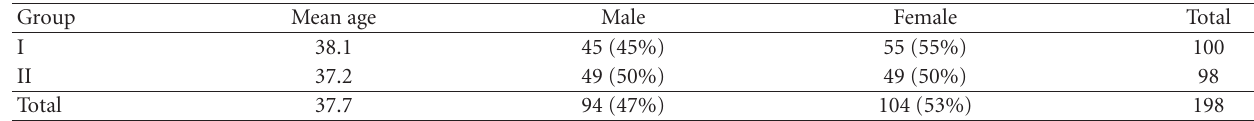
Table 1: Age and gender distribution.